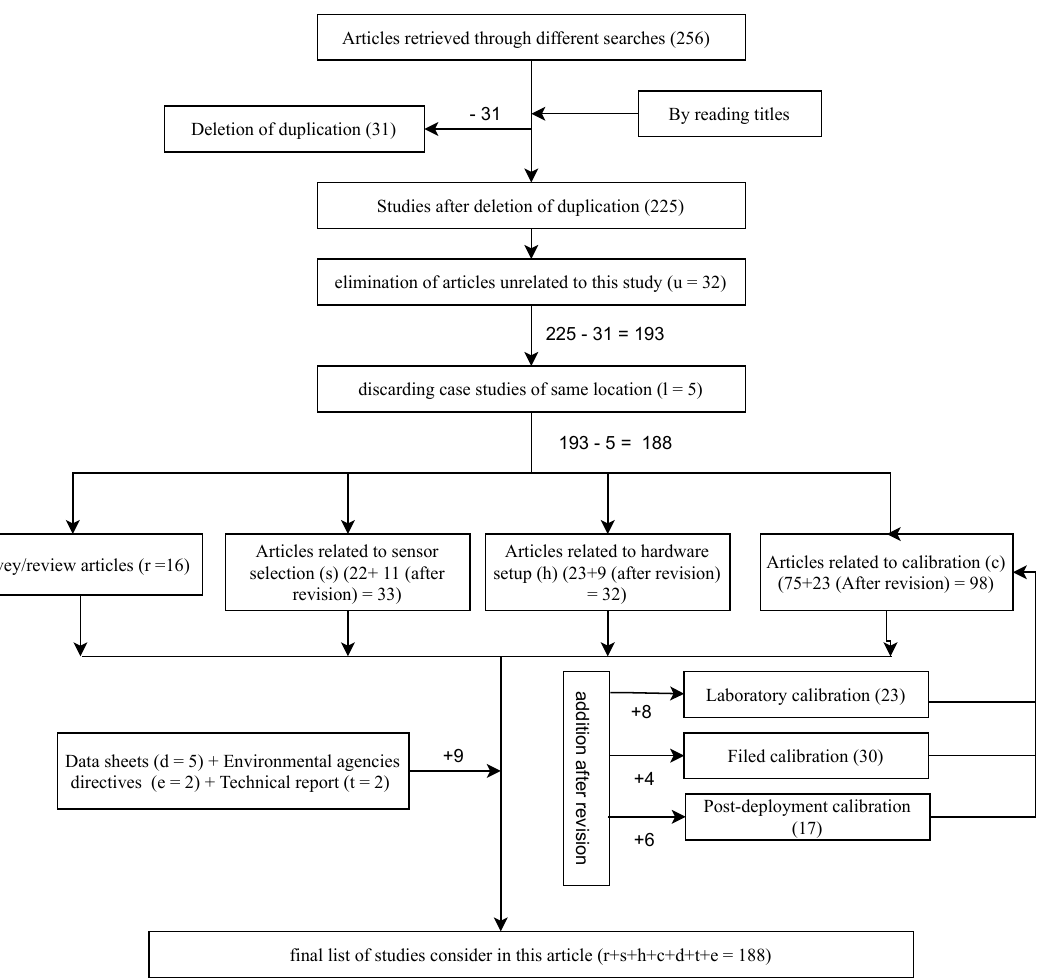
Figure 1. Flow chart explaining literature review